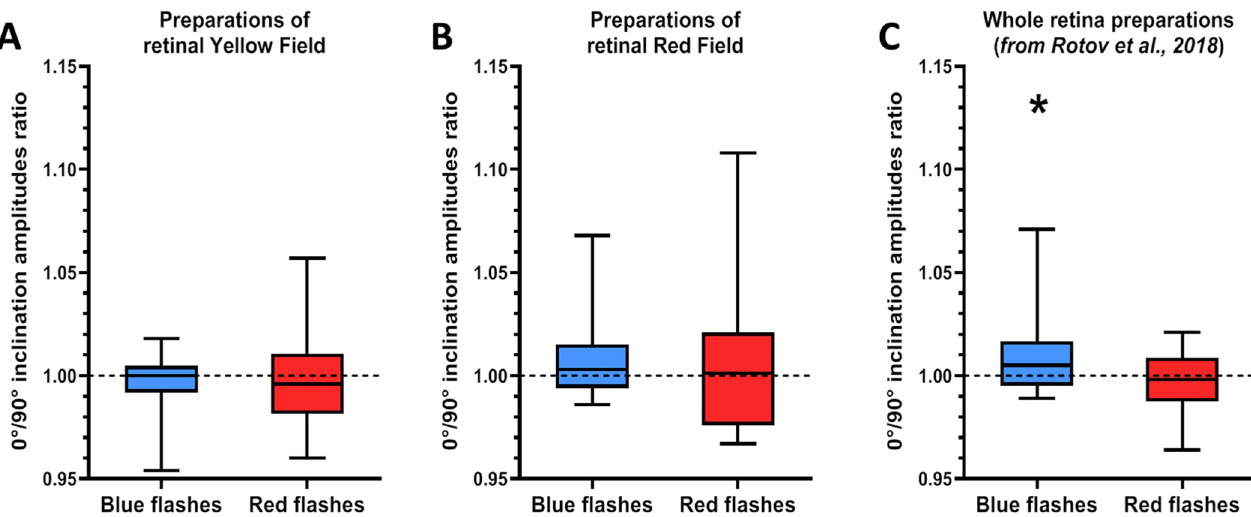
Fig 5. Analysis of potential effect of MF inclination change on the response maximum (amplitude). Y-axis shows the ratio of the response maximum recorded under magnetic inclination 0˚ to the response maximum for inclination 90˚. (A) Results for yellow field preparations. n = 16 for responses both to blue and red flashes. (B) Results for red field preparations. n = 15 for responses both to blue and red flashes. For both types of retinal fields no significant changes in response maximum’s ratio were detected by Student’s one sample t-test. (C) Results for total retinal preparations from a previous study [15]. n = 20 for responses both to blue and red flashes. Ratio of amplitudes recorded under 0˚/90˚ inclinations under blue flashes was significantly different from 1 (Student’s one sample t-test, t = 2.192, p = 0.041). For red flashes, no significant changes from 1 for response maximum’s ratio were detected. Data presented as medians (black horizontal lines) and quartiles (boxes and